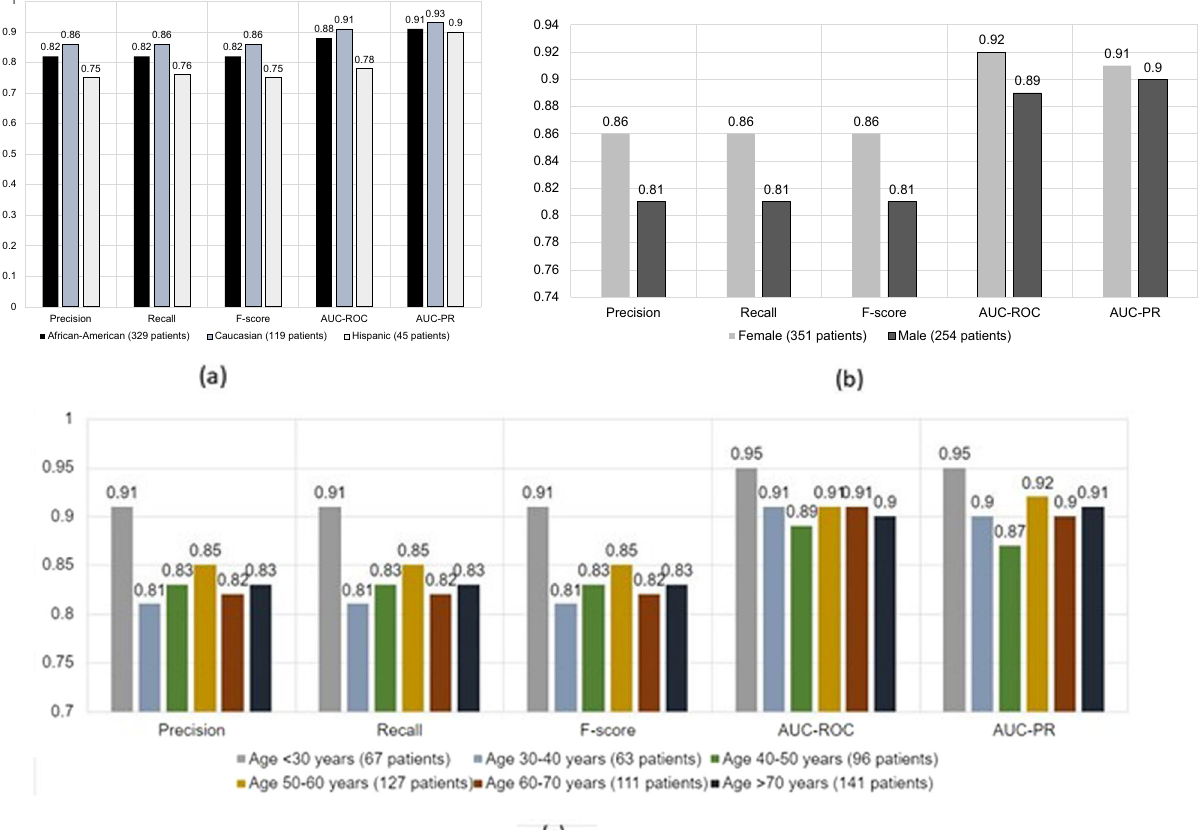
Fig. 3 Performance strati fi cation of the best performaing model based on Early fusion. a strati fi cation based on race and ethnicity, b strati fi cation based on gender, c strati fi cation based on